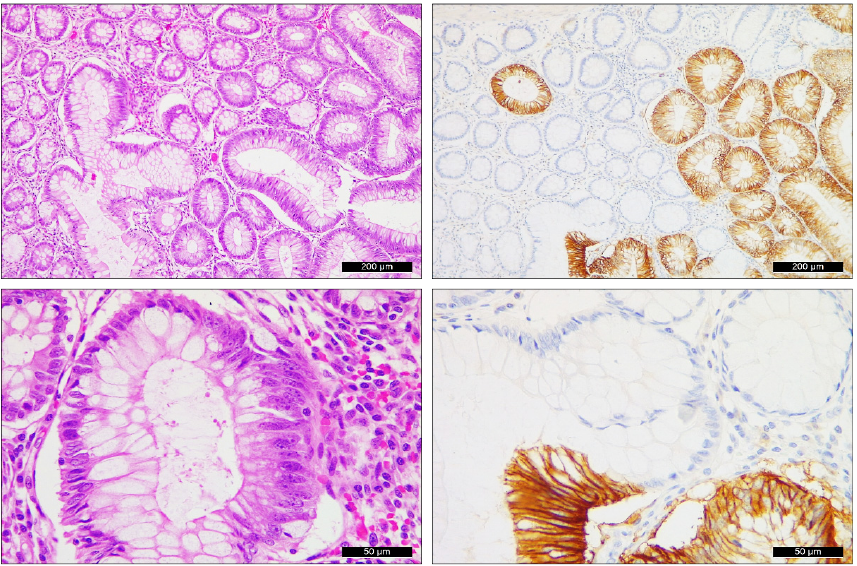
Figure 2. Selective CAIX expression in areas with moderate to severe dysplasia next to rectal adenocarcinoma ( upper row 10 × , lower row 40 ×